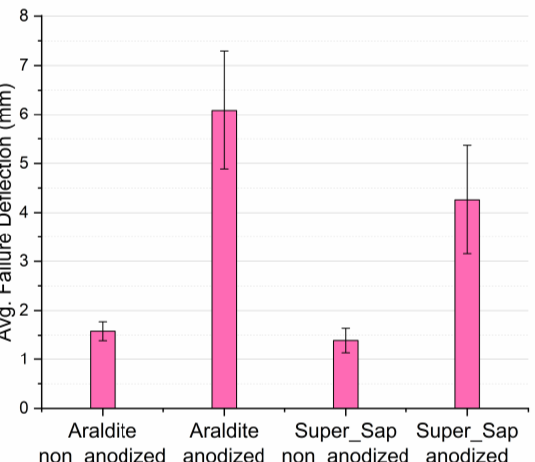
Figure 9. Bar diagram for the average flexural failure deflection values of all four types of joints manufactured and tested.